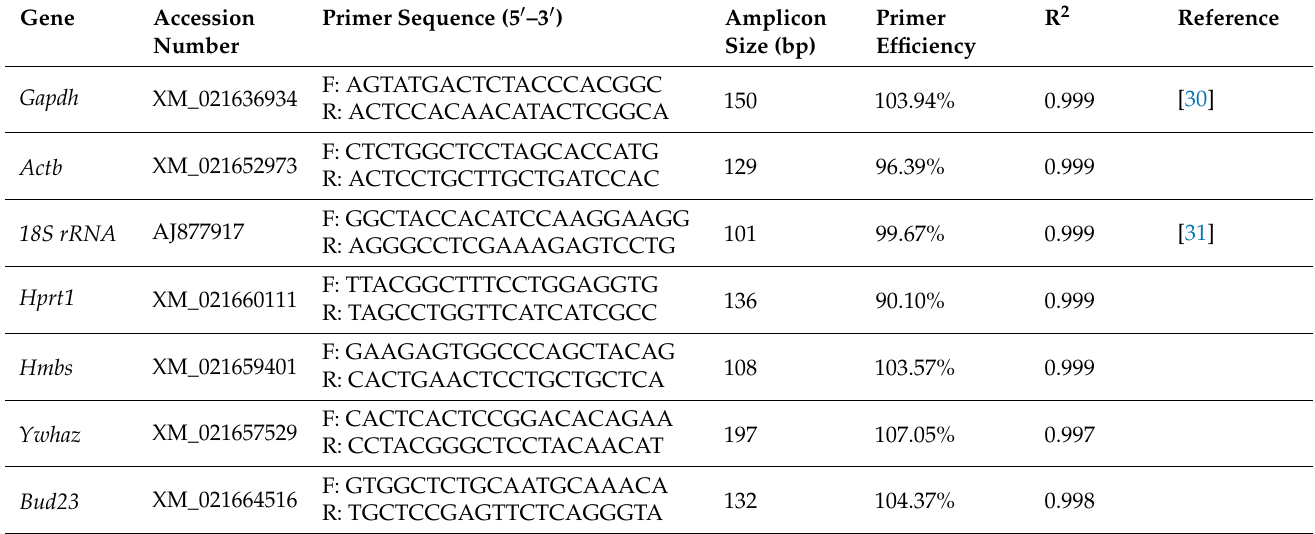
Table 1. Mongolian gerbil primer sequences used in this study for quantitative polymerase